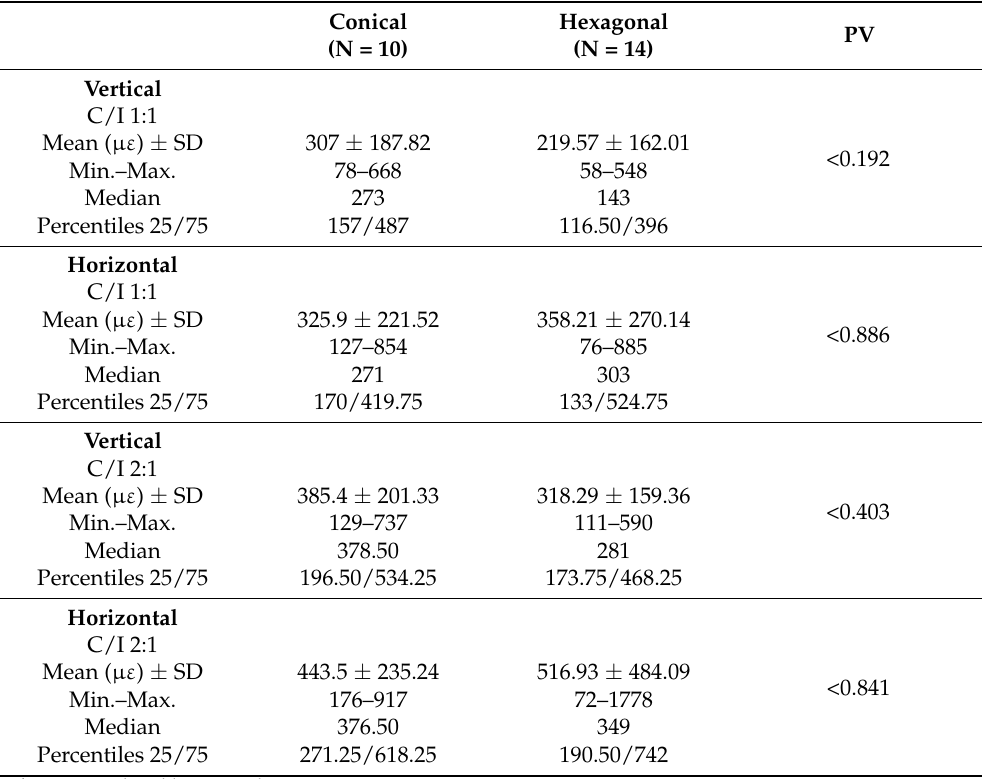
Table 5. Intragroup comparison of hexagonal and conical connection maximum values of the BLI when C/I ratio is 1:1 and 2:1.